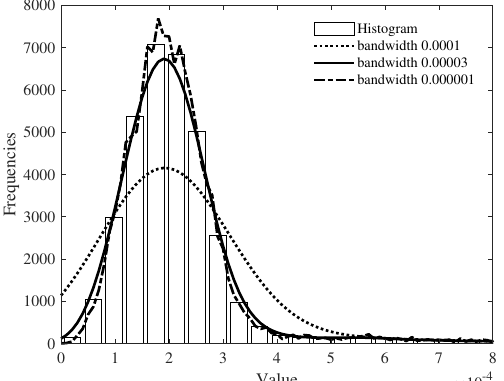
Figure 11. Relation between kernel bandwidth and kernel density estimation.